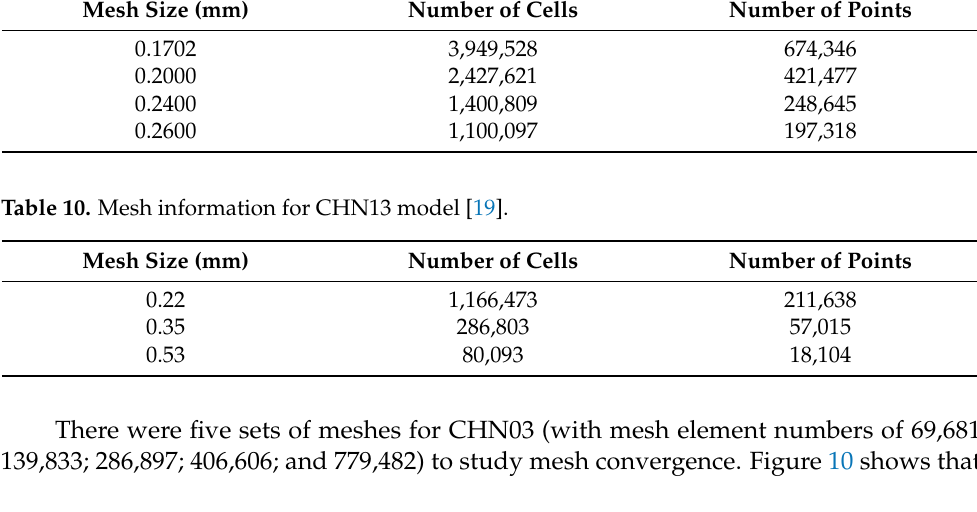
Figure 9. Cartesian mesh example.